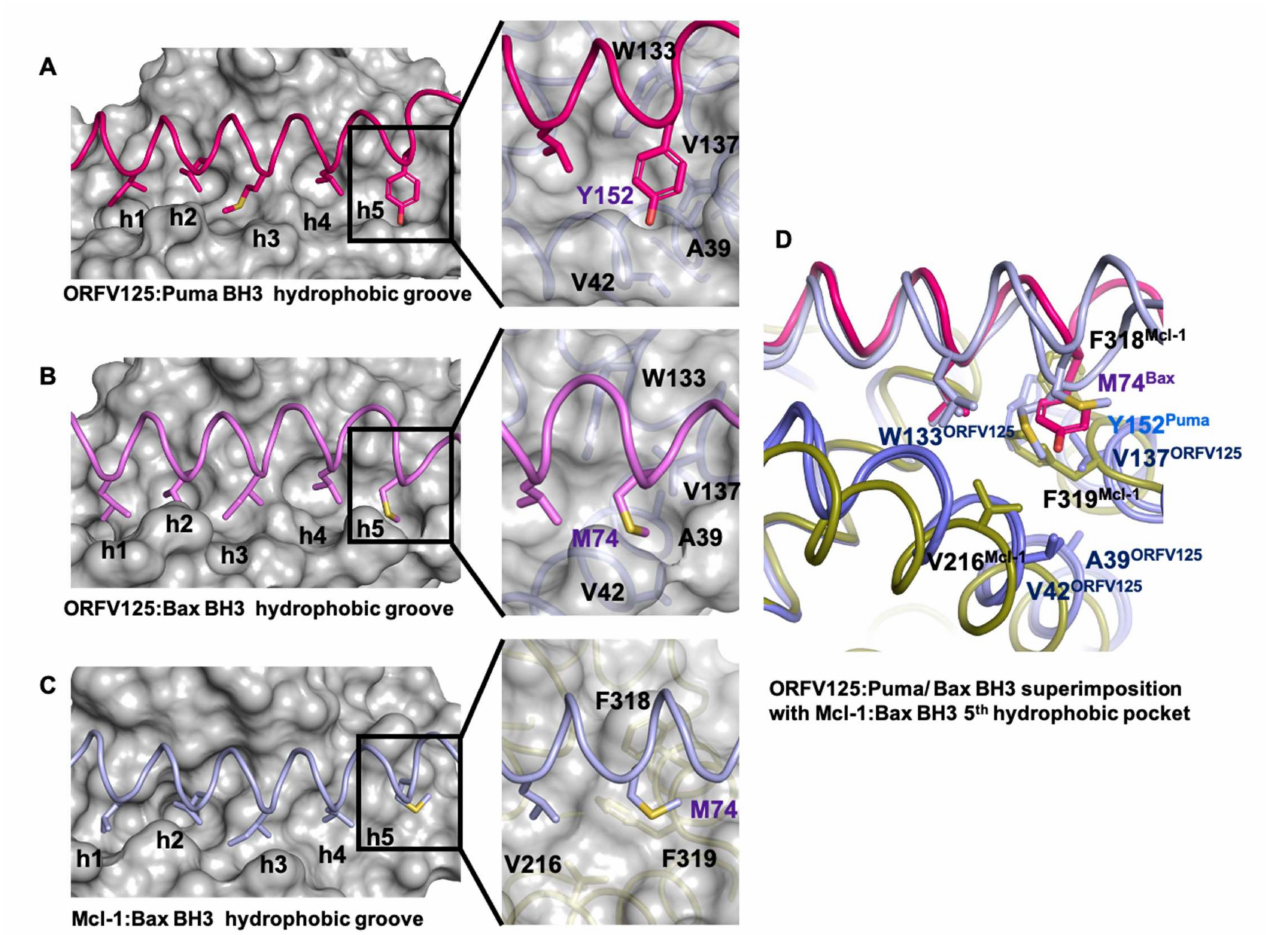
Figure 4. Engagement of the fifth hydrophobic pocket in ORFV125 and Mcl-1. ( A ) Hydrophobic binding groove of ORFV125:Puma BH3 complex. Five hydrophobic pockets in the binding groove are labelled h1-h5. The surface of the ORFV125 is shown in grey with side chains of the key residues in pocket h5 shown as sticks. Puma BH3 is shown as sticks (hot pink). An enlarged view of the fifth hydrophobic pocket of ORFV125 is shown in the middle panel with a cartoon tube of the ORFV125 backbone (slate), with residues involved in forming the fifth hydrophobic pocket labelled. ( B ) Hydrophobic binding groove of ORFV125:Bax BH3 complex (PDB ID 7ADT). ORFV125 is shown as in ( A ), Bax BH3 is shown as sticks (magenta). ( C ) Hydrophobic binding groove of Mcl-1:Bax BH3 complex (PDB ID 3PK1). The surface of Mcl-1 is shown in grey with side chains of the key residues in pocket h5 shown as sticks. Bax BH3 is shown as sticks (sky blue). ( D ) The enlarged view of a superimposition of the fifth hydrophobic pocket formed by ORFV (slate):Puma (hot pink) BH3, ORFV125 (slate):Bax (light blue) BH3 and Mcl-1 (olive):Bax (light blue) BH3. ORFV125 and Mcl-1 peptide backbones are shown as cartoon tubes, sidechains of the residues that form the fifth hydrophobic pocket are shown as sticks and labelled. Puma BH3 (hot pink) and Bax BH3 (sky blue) are shown as cartoon and